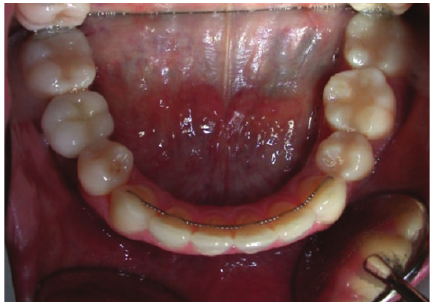
Figure 20: Clinical view of definitive crown.